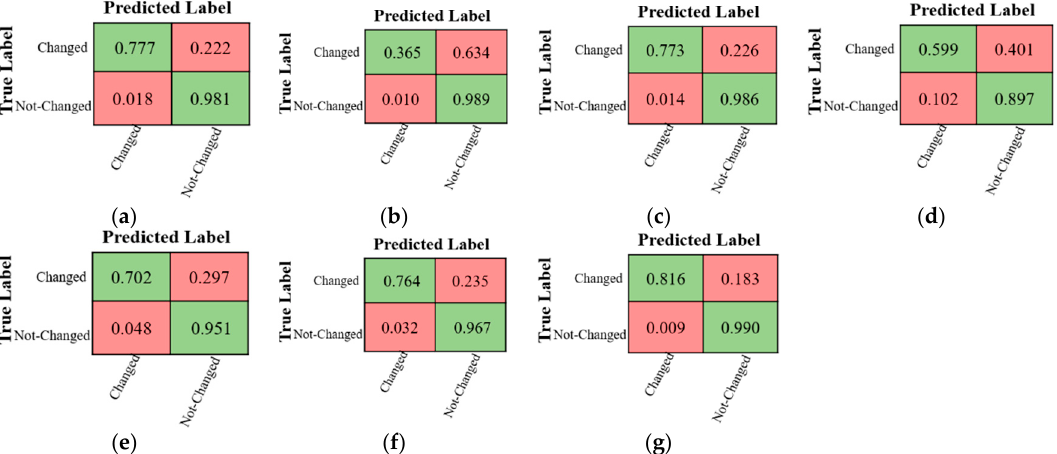
Figure 17. The confusion matrices of different CD methods for the Hyperspectral-River dataset. ( a ) CVA-SVM, ( b ) MAD-SVM, ( c ) PCA-SVM, ( d ) IR-MAD -SVM, ( e ) SFA-SVM, ( f ) 3D-CNN, and ( g ) Proposed Method.